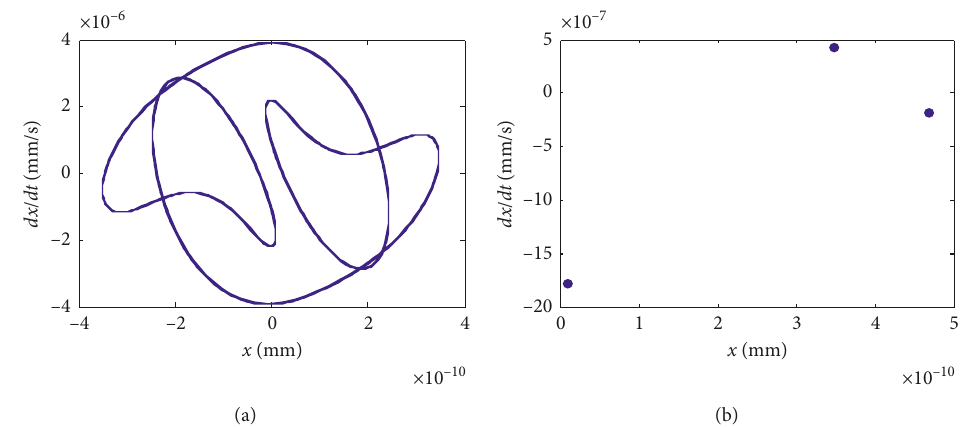
Figure 10: System response for ω � 15000r/min. (a) Phase portraits. (b) Poincar´e